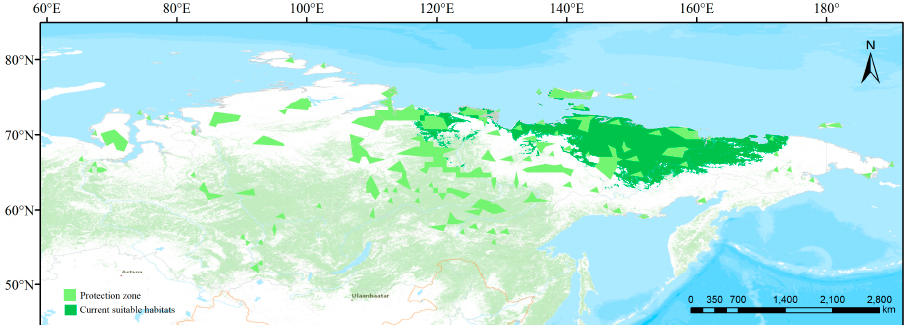
Figure 5. Protection gaps. The existing protected areas are overlaid with the current suitable distribution areas for the conservation vacancy analysis, and the remaining dark green part represents areas that are not under conservation management.